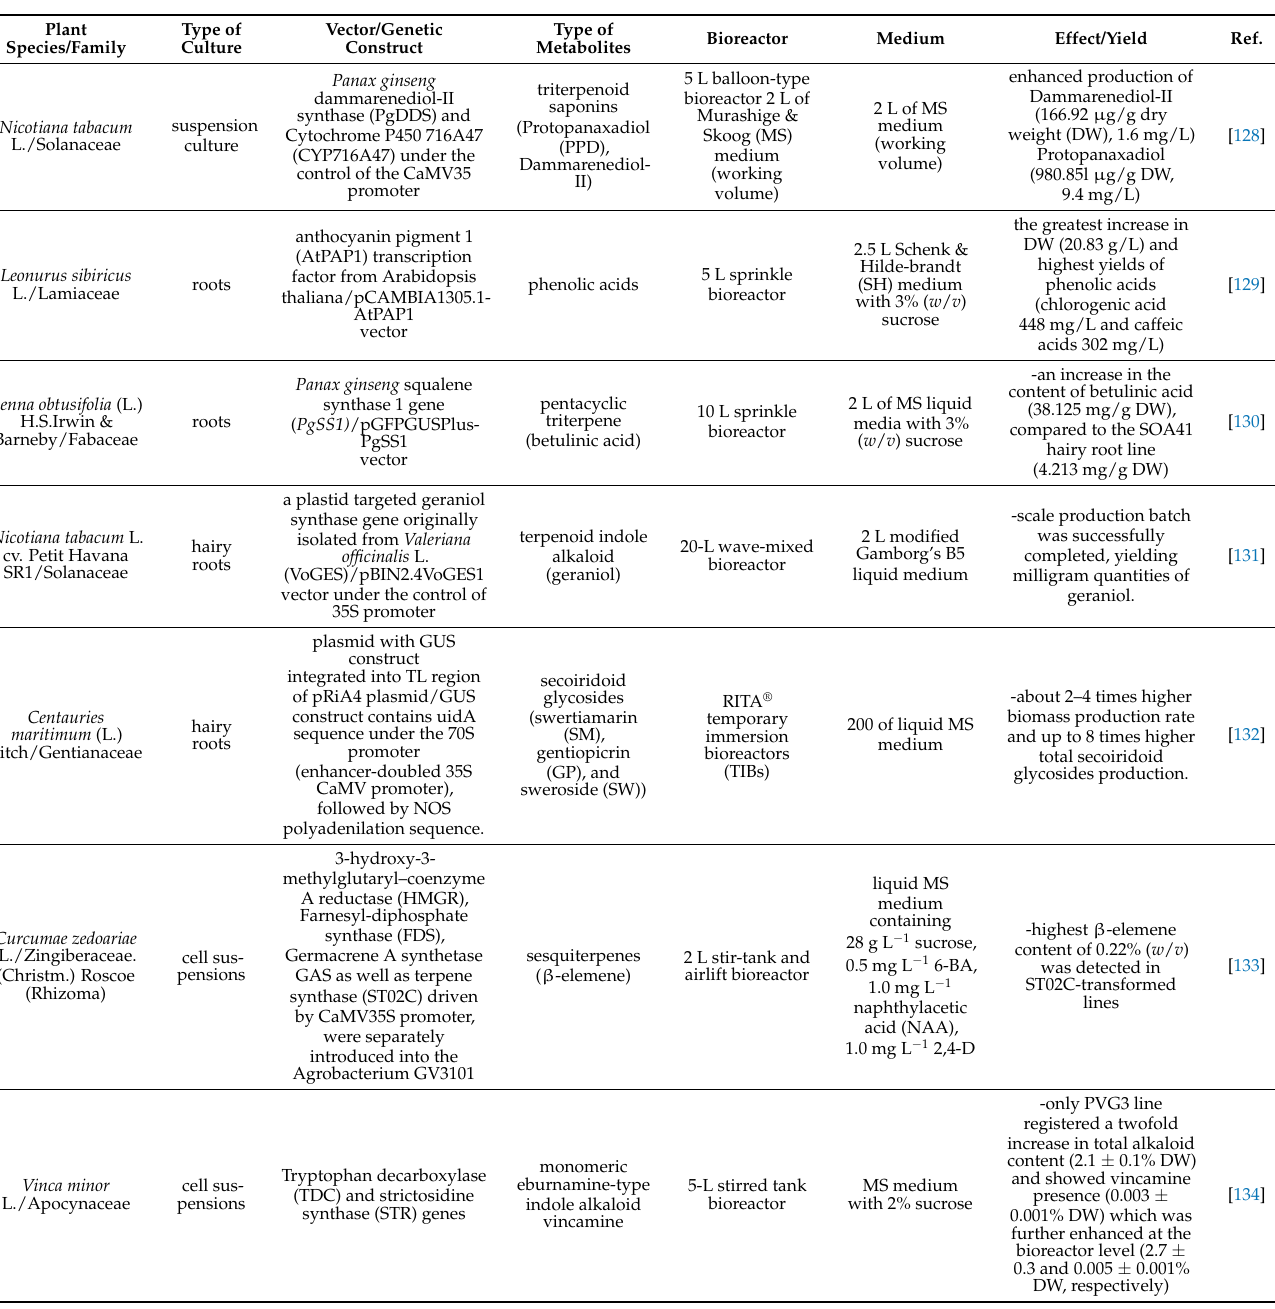
Table 1. Examples of increasing the production of selected secondary metabolites by interfering with metabolic pathways in transgenic cultures grown in